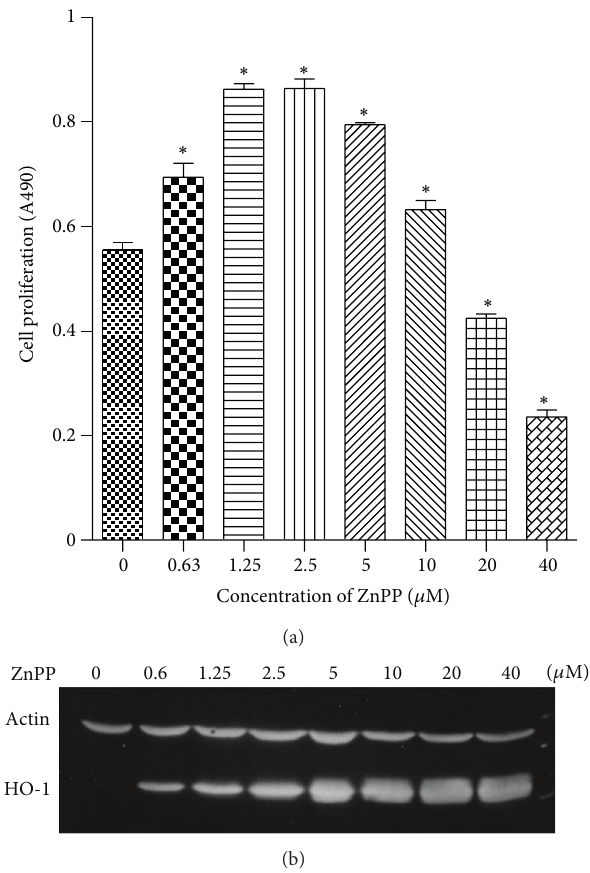
Figure 1: Effect of ZnPP on cell proliferation and HO-1 expression of PC-3 cells. (a) PC-3 cells were treated with various concentrations of ZnPP for 48h, and number of live cells was estimated by MTS cell proliferation assay as described in Section 2. Results were expressed as Absorbance at 490nm (mean ± S . E.). 𝑁 = 3 ; ∗ 𝑃 < 0.05 compared with untreated control. (b) PC-3 cells were treated with various concentrations of ZnPP for 24h, and HO-1 expression was determined by western blot analysis as described in Section 2 using specific antibodies against 𝛽 -actin and HO-1. Immunoreactive protein bands detected by WesternDot 625 appeared as fluorescent